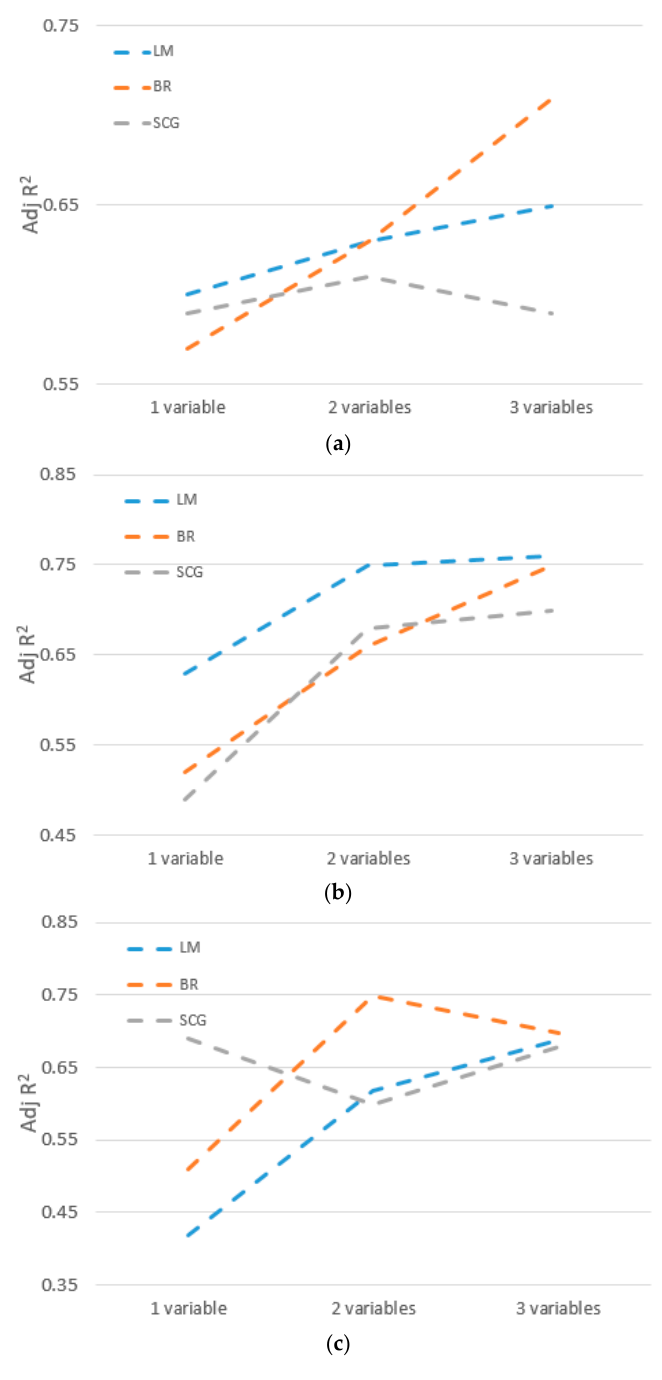
Figure 7. Adjusted R 2 values: ( a ) for Kimbulawala; ( b ) for Kotte canal; ( c ) for Kotte North .